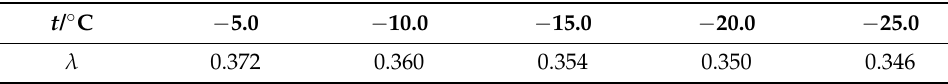
Table 4. Thermal conductivity of FR-1 refrigerant carrier.